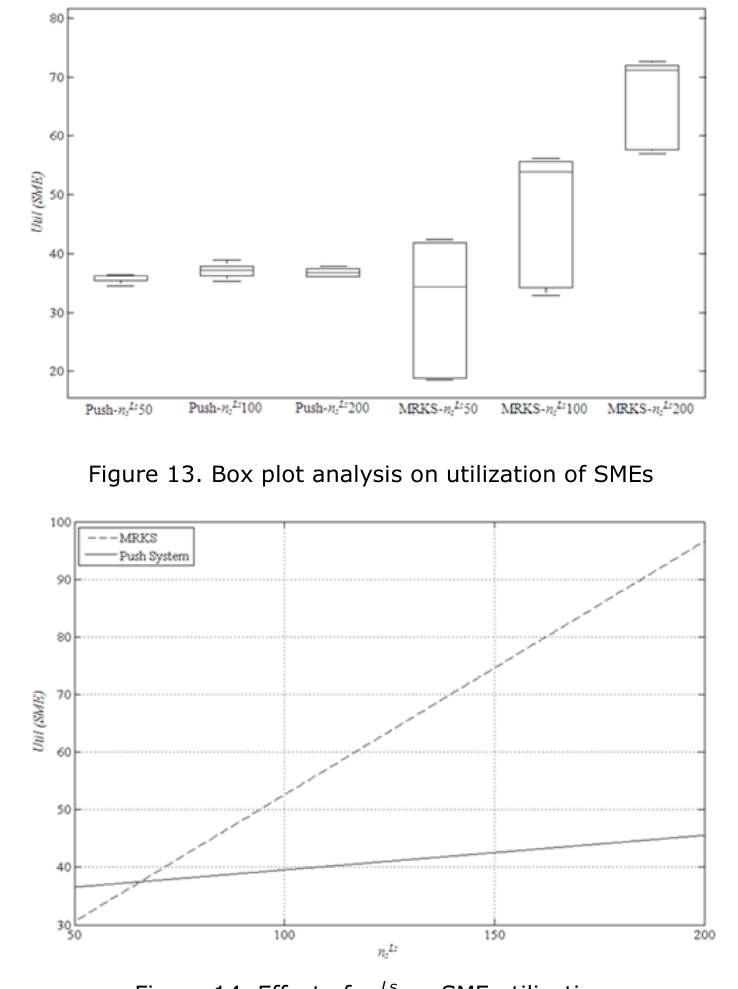
Figure 14. Effect of n sLs on SME